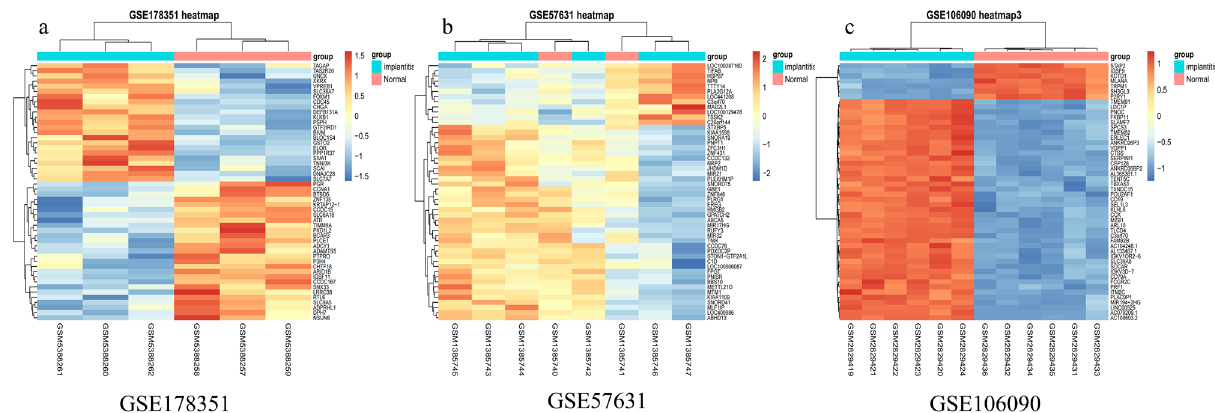
Figure 2. Heatmap of the top 50 up- and down-regulated genes ( a GSE178351, b GSE57631, c GSE106090). Legend on the top right indicates the log fold change of the